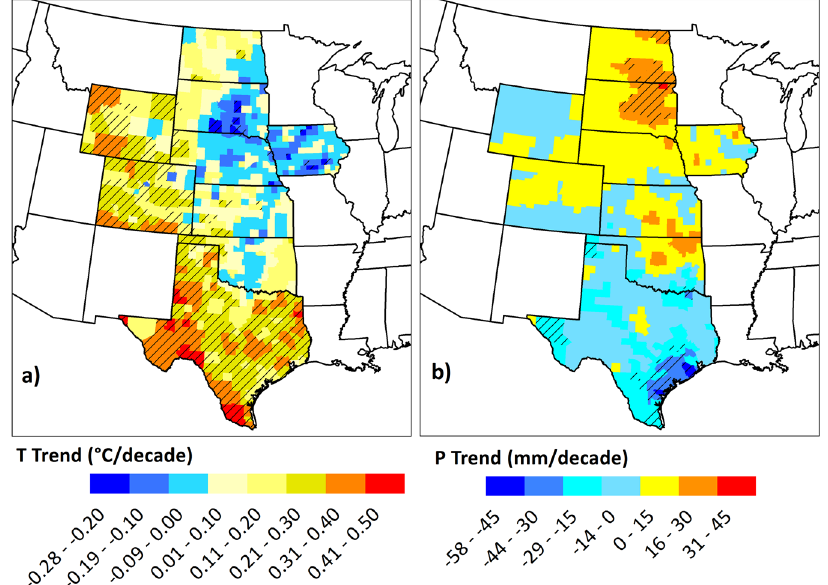
Figure 4. Trends in growing season (May 1 st to September 30 th ) ( a ) Average Air Temperature ( b ) Precipitation totals in the Great Plains counties over the period 1968–2013. Temperature trends are represented in °C decade − 1 and precipitation trends are represented in mm decade − 1 . Counties with striped lines indicate that the trend in the county was statistically significant to 95% confidence level. We created the maps using ESRI ArcMap 10.4.1 software